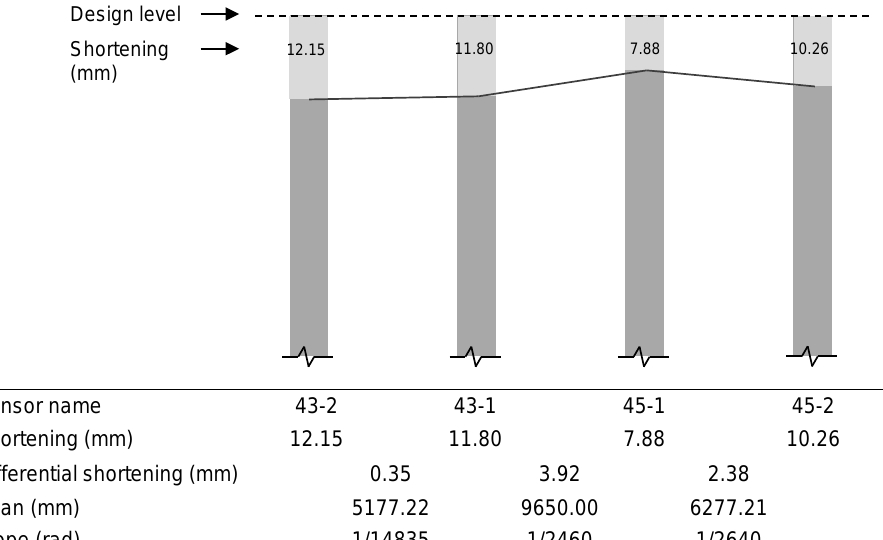
Figure 14. Differential shortenings for walls and columns in tower